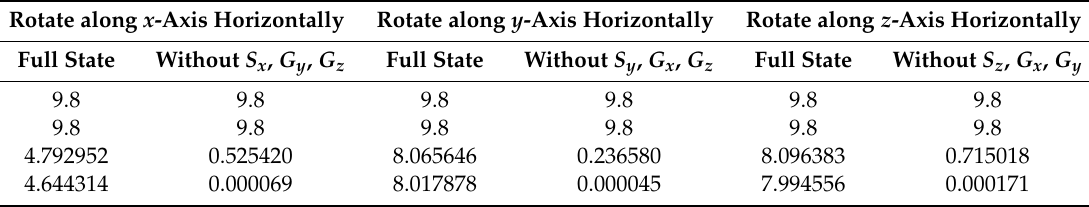
Table 11. SVD of Scale Factor Error.